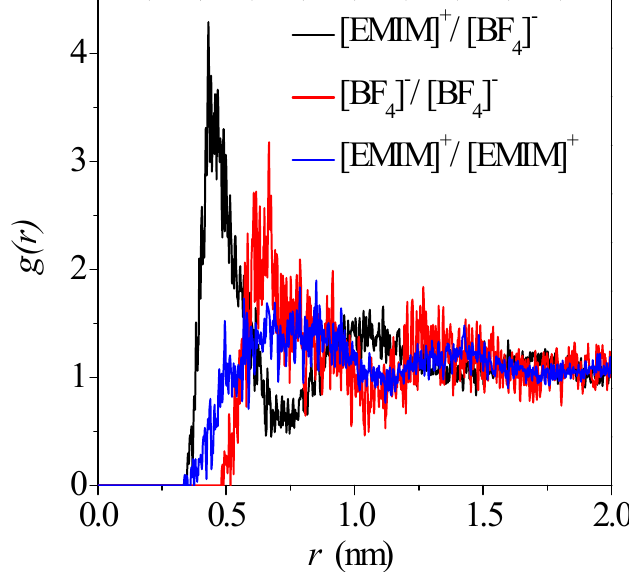
Figure 6. Ion–ion radial distribution functions (RDFs) for the [EMIM] + /[BF 4 ] − electrolyte on the non-rough neutral electrode surface.